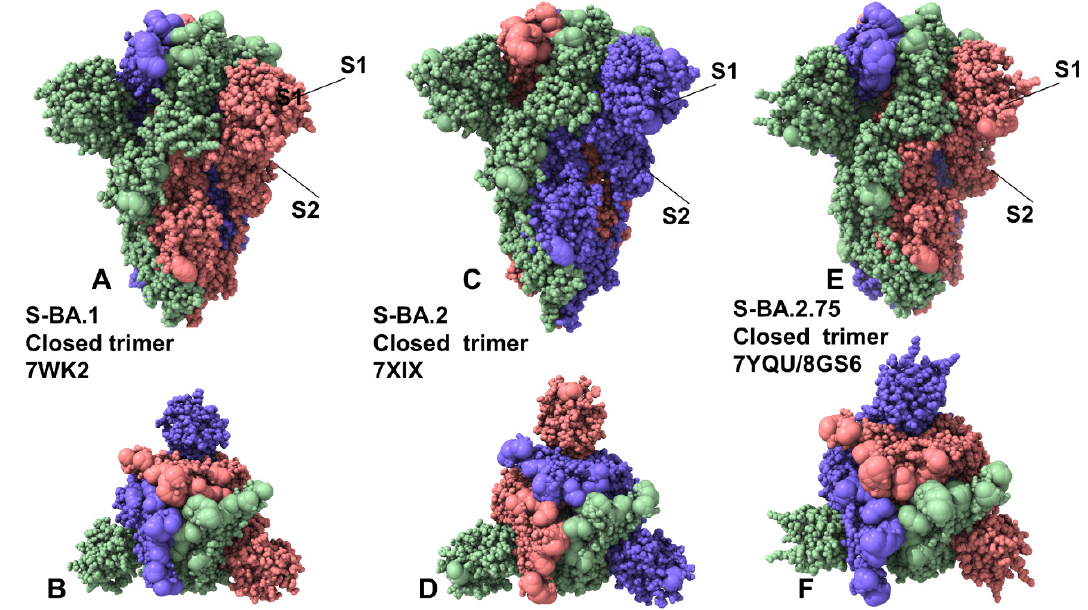
Figure 1. Structural organization and mapping of the Omicron mutations in the SARS-CoV-2 S closed Omicron BA.1, BA.2, and BA2.75 trimers. ( A ) The cryo-EM structure of the S Omicron BA.1 trimer in the closed 3RBD-down form (pdb id 7WK2). ( B ) The top view of the closed BA.1 trimer. The S trimer is shown in full spheres and colored by the protomer. The Omicron BA.1 sites (A67, T95I, G339D, S371L, S373P, S375F, K417N, N440K, G446S, S477N, T478K, E484A, Q493R, G496S, Q498R, N501Y, Y505H, T547K, D614G, H655Y, N679K, P681H, N764K, D796Y, N856K, Q954H, N969K, L981F) are shown in larger spheres. ( C ) The cryo-EM structure of the S Omicron BA.2 trimer in the closed, 3 RBD-down form (pdb id 7XIX). ( D ) The top view of the closed BA.2 trimer. The Omicron BA.2 sites (T19I, G142D, V213G, G339D, S371F, S373P, S375F, T376A, D405N, R408S, K417N, N440K, S477N, T478K, E484A, Q493R, Q498R, N501Y, Y505H, D614G, H655Y, N679K, P681H, N764K, D796Y, Q954H, N969K) are shown in large spheres. ( E ) The cryo-EM structure of the S Omicron BA.2.75 trimer in the closed, 3 RBD-down form (pdb id 7YQU/8GS6). ( D ) The top view of the closed BA.2.75 trimer. ( F ) The top view of the closed S Omicron BA.2.75 trimer. The Omicron BA.2.75 sites (T19I, G142D, K147E, W152R, F157L, I210V, V213G, G257S, G339H, S371F, S373P, S375F, T376A, D405N, R408S, K417N, N440K, G446N, N460K, S477N, T478K, E484A, Q498R, N501Y, Y505H, D614G, H655Y, N679K, P681H, N764K, D796Y, Q954H, N969K) are shown in larger spheres.